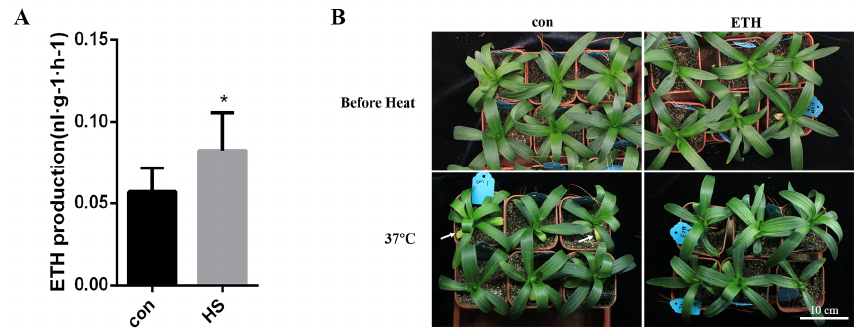
Figure 1. The production of ethylene in lily leaves under heat stress. ( A ) Examination of ethylene production of lily leaves after 3 h of heat stress at 37 ◦ C. ( B ) Phenotype of lily under a heat stress of 37 ◦ C for 26 h after pretreatment with 2 ppm ETH for 3 h. The white arrow points to the leaves that turned yellow. Bar: 10 cm T -test analysis of variance was employed to identify treatment means that differed statistically. Samples with stars are significantly different; * p < 0.05.